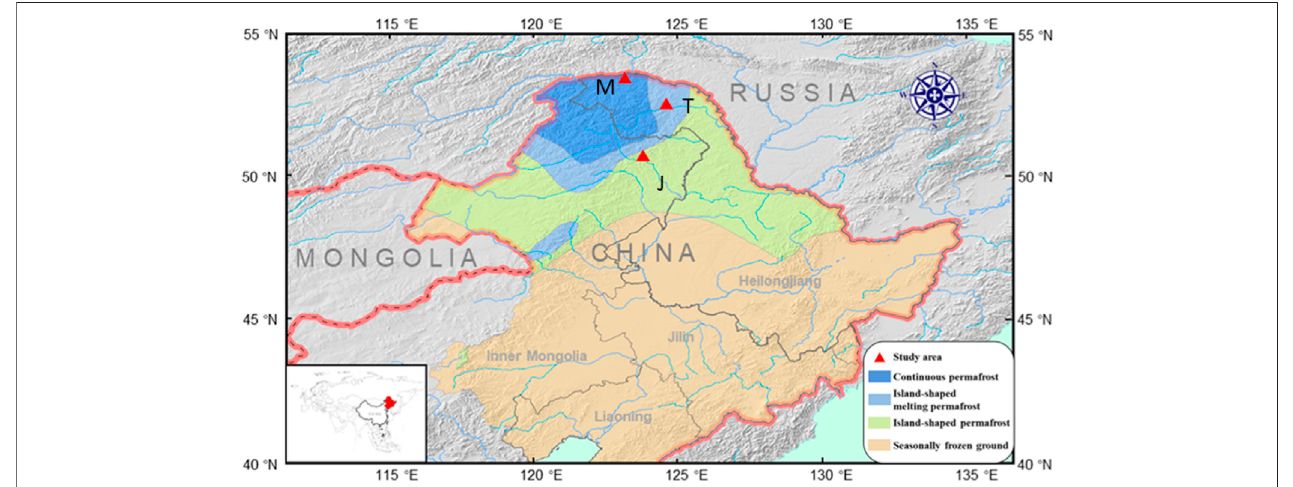
FIGURE 1 | Schematic diagram of the sample plot location in the research area.